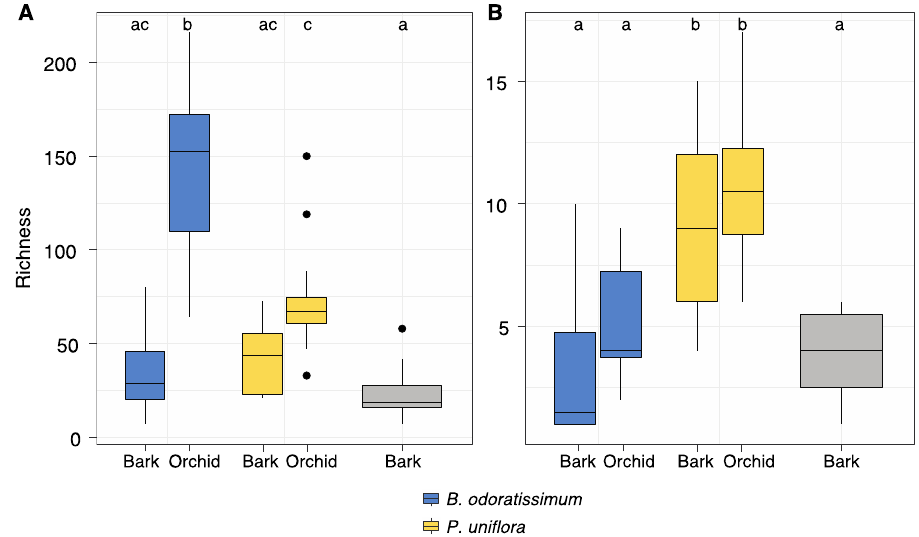
Figure 1. Richness of total ( A ) and orchid-associated ( B ) fungi associated with the orchid species B. odoratissimum and P. uniflora , and the bark of P. weinmannifolia (blue), Q. yiwuensis (yellow) and B. percoriacea